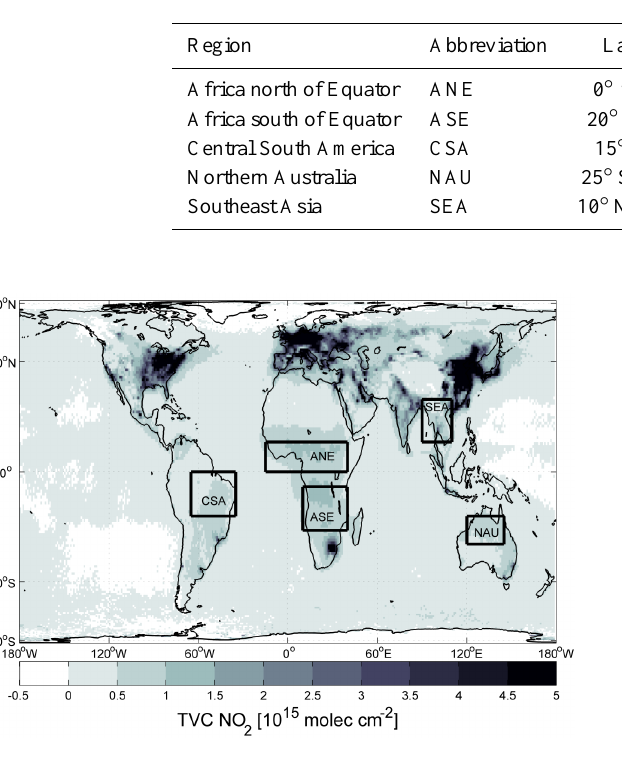
Fig. 1. Global mean tropospheric NO 2 vertical columns (2007– Figure 1. Global mean tropospheric NO 2 vertical columns (2007-2011) retrieved from GOME-2 2 measurements. Africa north of equator (ANE, 0° to 10°N and 15°W to 40°E), Africa south of 3 2011) retrieved from GOME-2 measurements. Africa north of equator (ASE, 20°S to 5°S and 10°E to 40°E), central South America (CSA, 15°S to 0° and 65°W 4 Equator (ANE, 0 ◦ to 10 ◦ N and 15 ◦ W to 40 ◦ E), Africa south of to 35°W), northern Australia (NAU, 25°S to 15°S and 120°E to 145°E), and Southeast Asia 5 Equator (ASE, 20 ◦ S to 5 ◦ S and 10 ◦ E to 40 ◦ E), central South (SEA, 10°N to 25°N and 90°E to 110°E) are highlighted by black rectangles (see also Table 1). 6 America (CSA, 15 ◦ S to 0 ◦ and 65 ◦ W to 35 ◦ W), northern Aus- tralia (NAU, 25 ◦ S to 15 ◦ S and 120 ◦ E to 145 ◦ E), and Southeast Asia (SEA, 10 ◦ N to 25 ◦ N and 90 ◦ E to 110 ◦ E) are highlighted by black rectangles (see also Table 1).